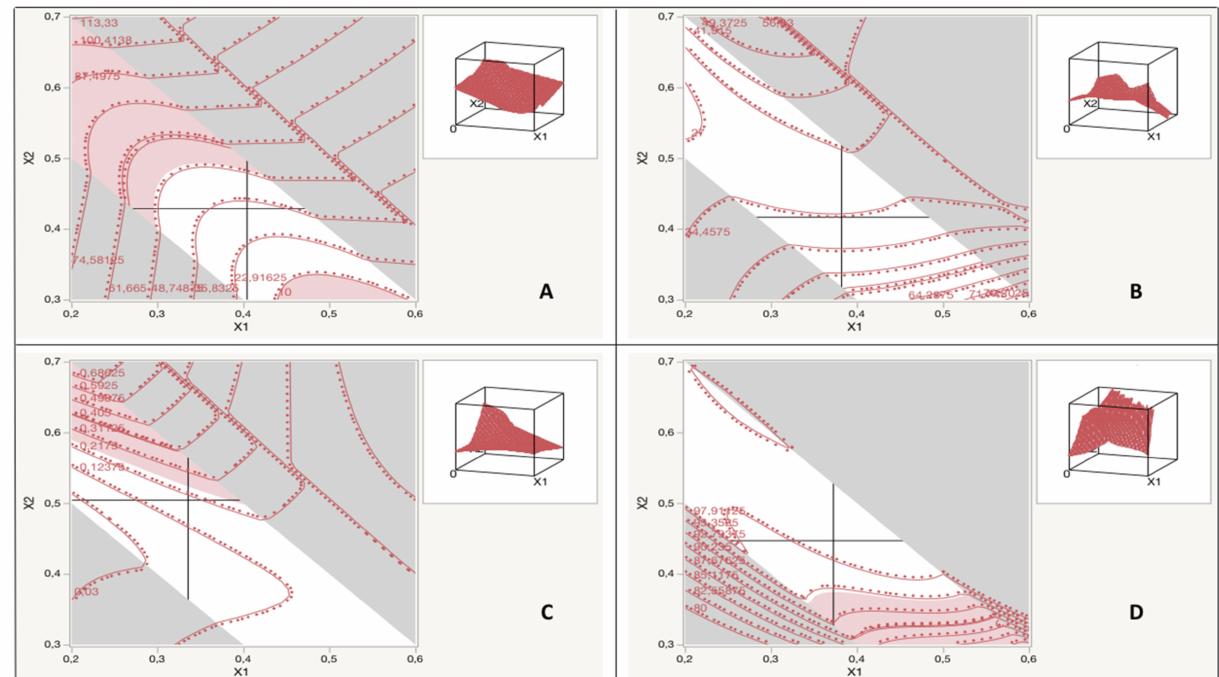
Figure 3. Contour profiler correlating independent variables with the ( A ) self-emulsification time (Y 1 ), ( B ) droplet size (Y 2 ), ( C ) PDI (Y 3 ), and ( D ) transmittance percentage (Y 4